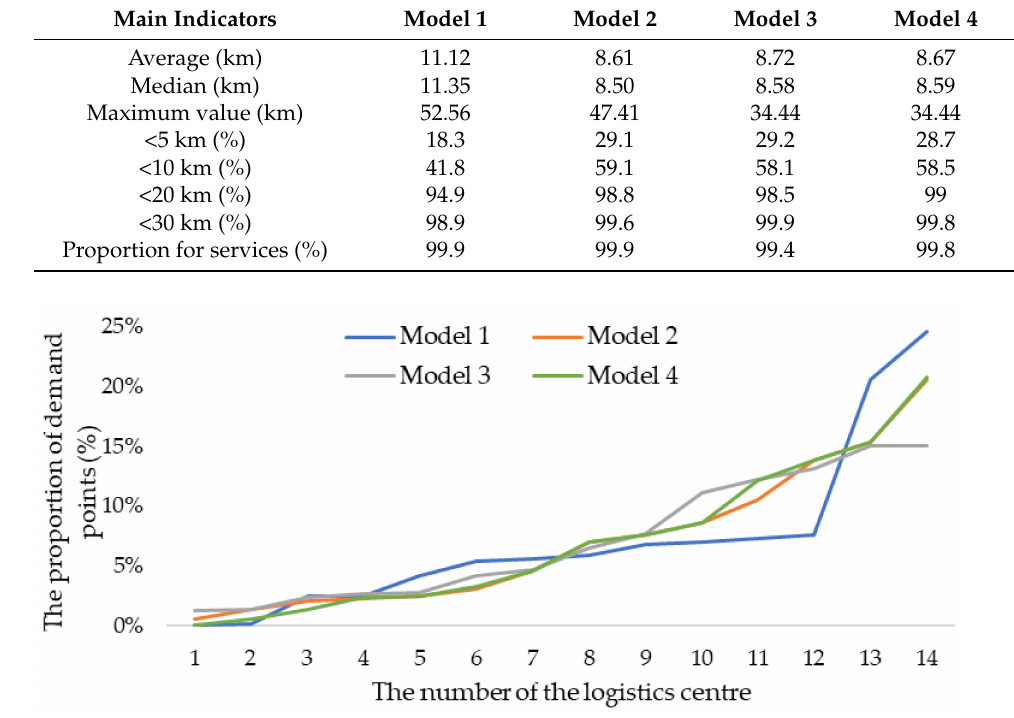
Figure 14. Changes in the proportion of demand points served by the logistics centre before and after